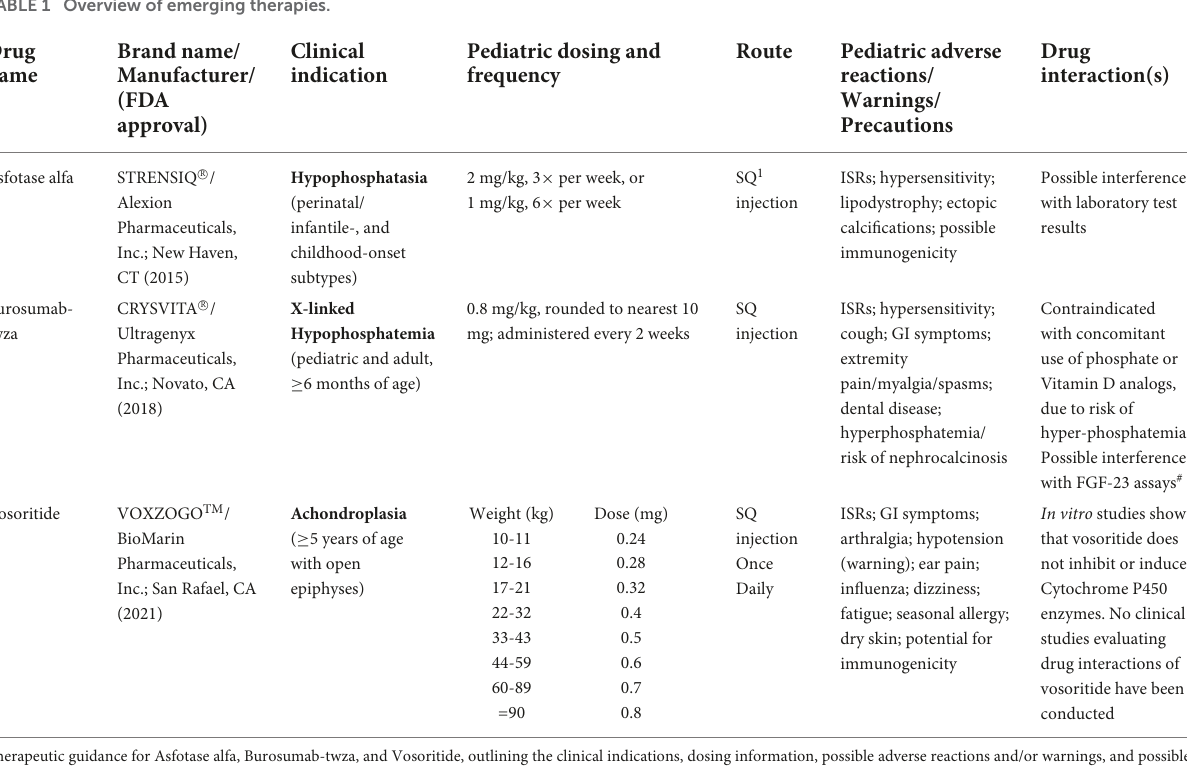
TABLE 1 Overview of emerging therapies.